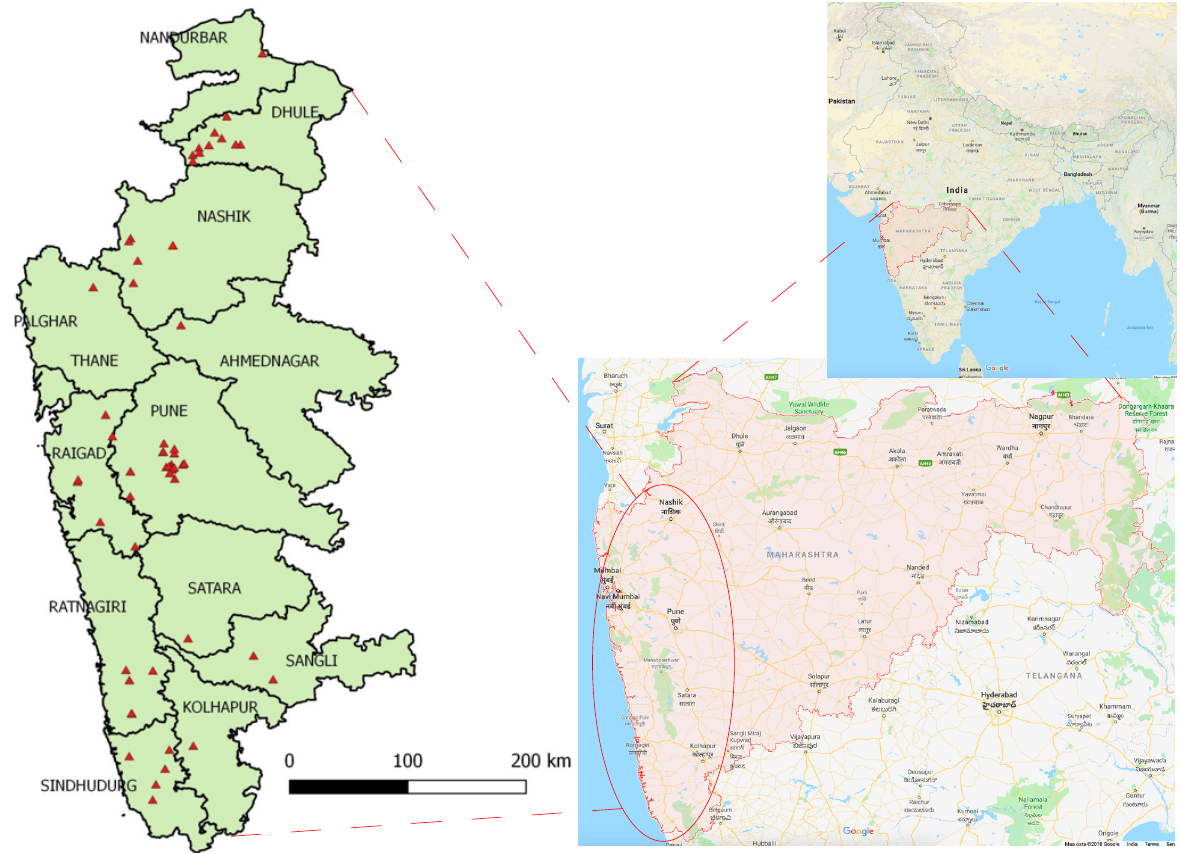
Figure 1. The survey localities from the study